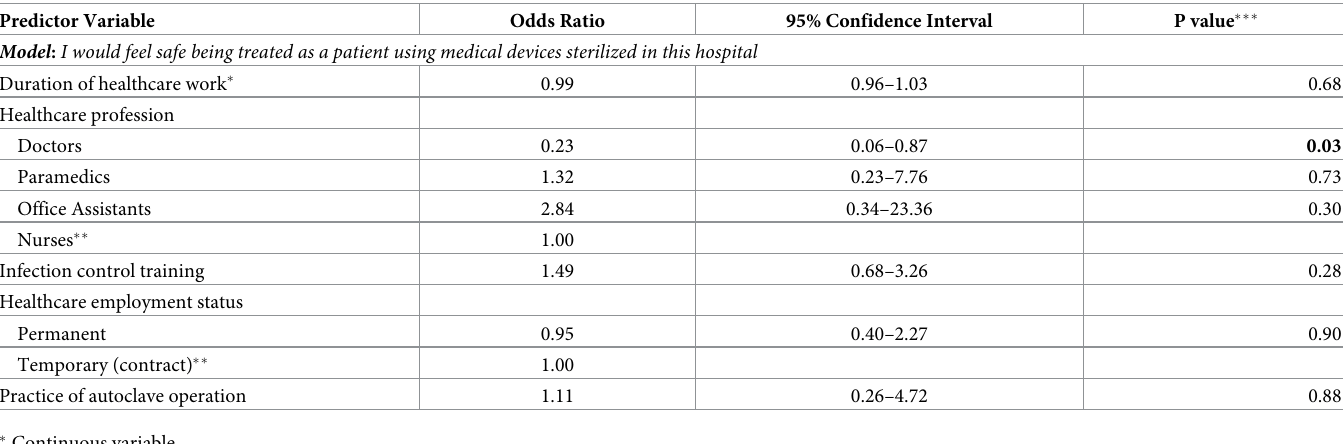
Table 11. Complex samples—ordinal regression model for the attitude of healthcare workers towards being treated as a patient. Predictor